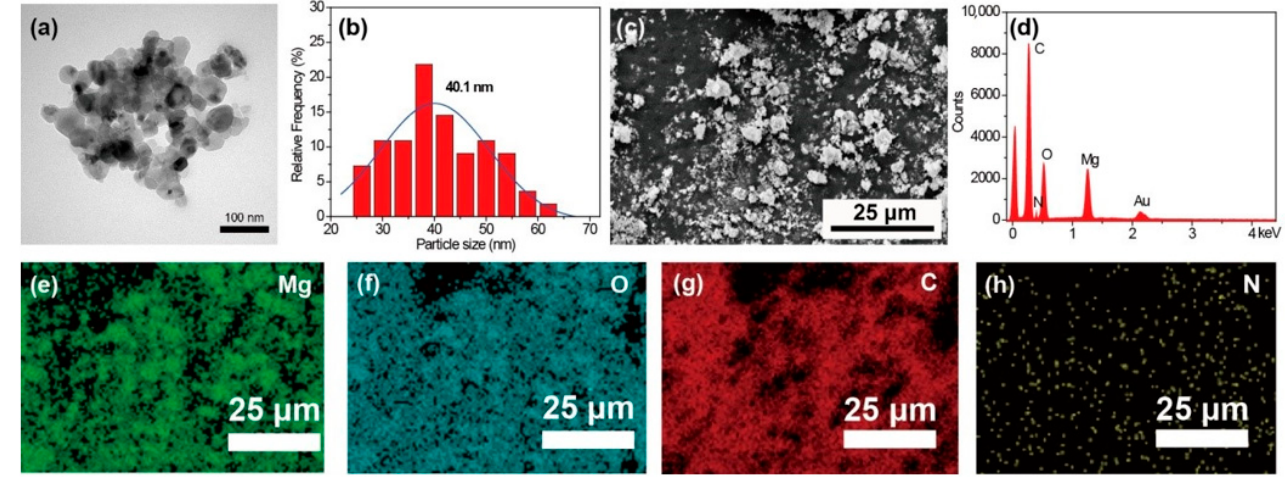
Figure 1. ( a ) Transmission electron microscopy (TEM) image; ( b ) particle size distribution of MgO; ( c ) scanning electron microscopy (SEM) image of MgO@CTAB; ( d ) energy-dispersive X-ray (EDX) result; EDX mapping element of ( e ) Mg, ( f ) O, ( g ) C, and ( h ) N.